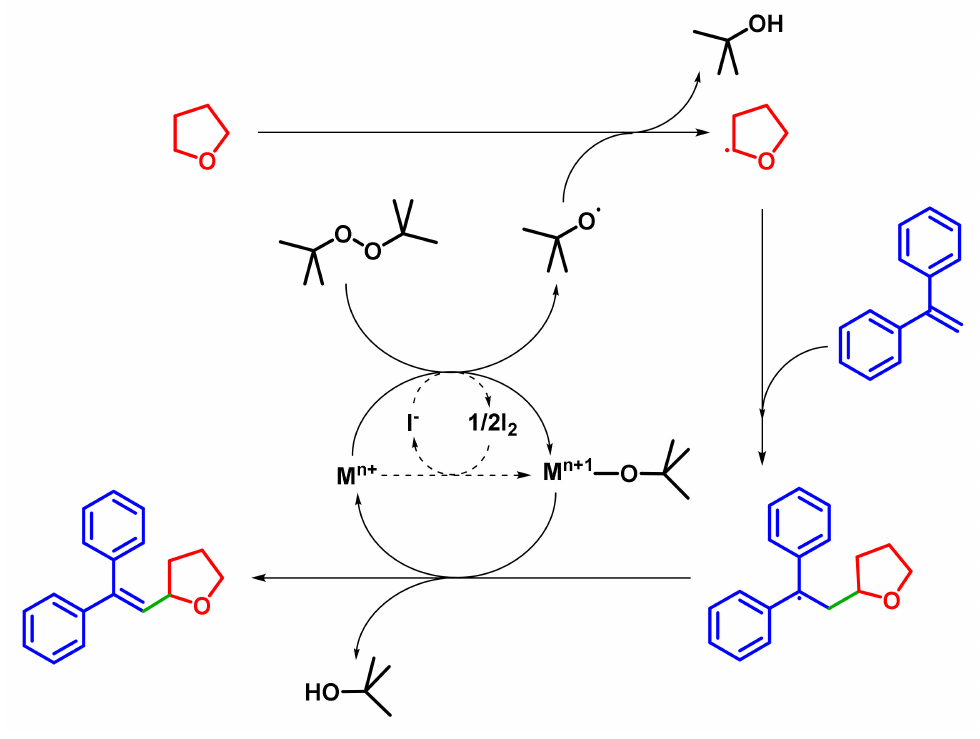
Figure 13. Proposed redox cycle for the cross-dehydrogenative coupling between 1,1- diphenylethylene and THF on the mixed oxide